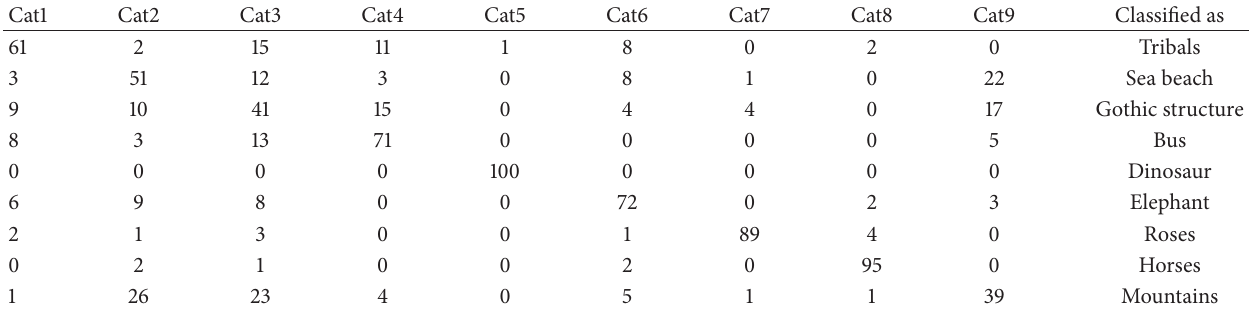
Table 3: Confusion matrix.